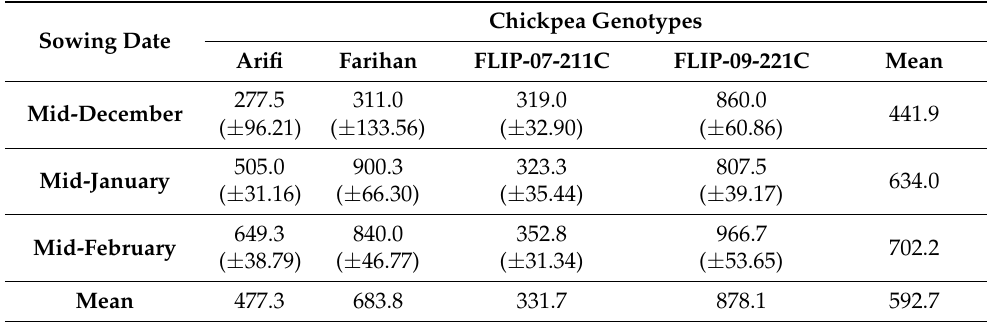
Table 4. Effects of sowing date and chickpea genotypes on AUDPC ± SD, 2017–2018 cropping